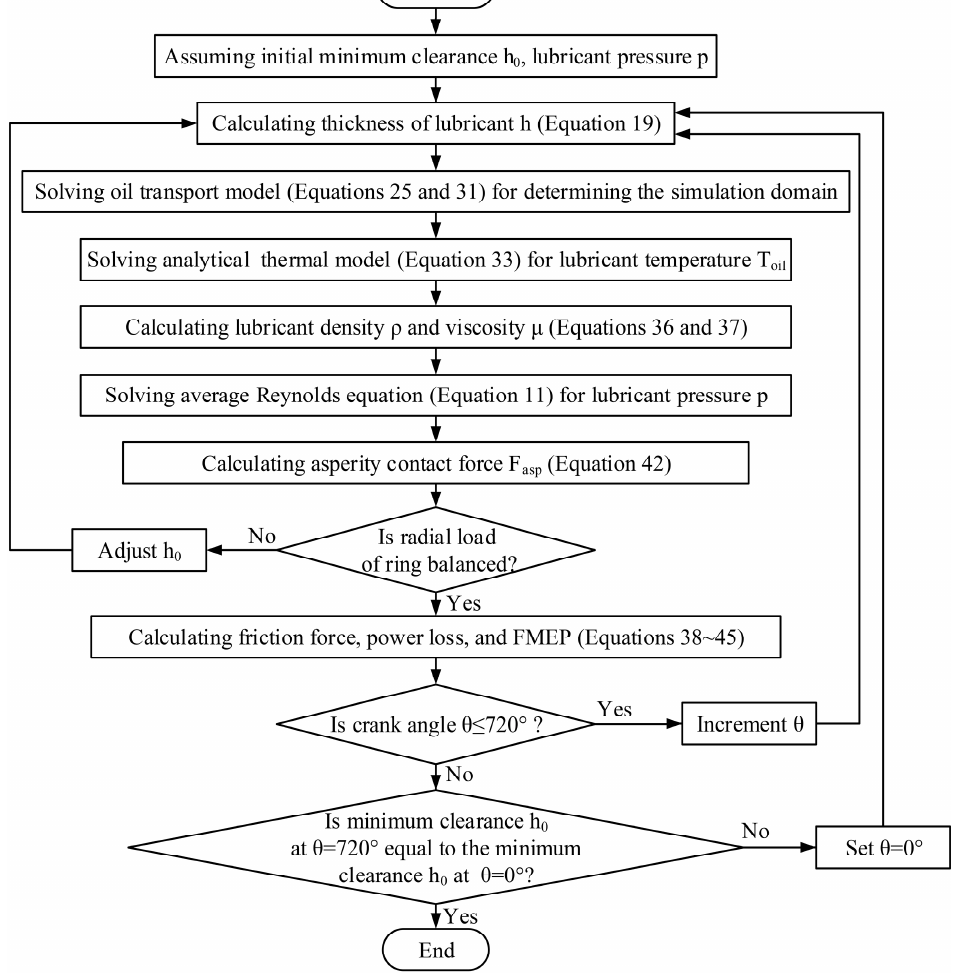
Figure 5. Calculation flow chart for the numerical model.